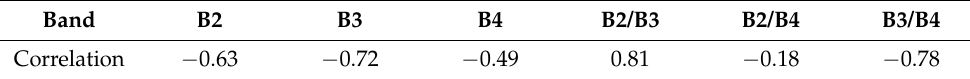
Table 2. Correlation